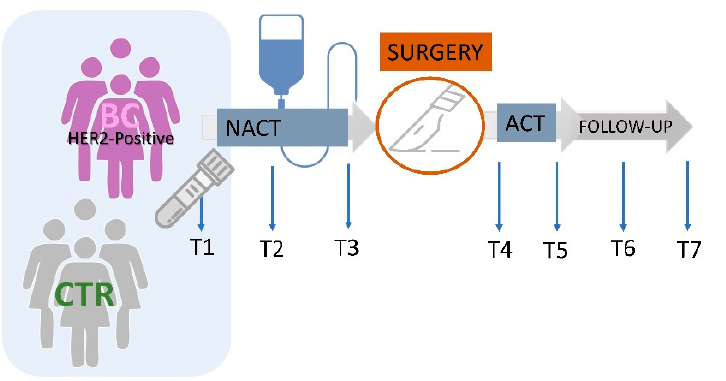
Figure 1. Schematic representation of the study. 1 H-NMR lipoproteins analysis was investigated in HER2-positive BC patients ( n = 43) at baseline (T1) and compared with those of the CTR group ( n = 28). In a subset of patients ( n = 32), plasma lipoproteins profiles were monitored during and after therapeutic interventions up to two-year follow-up: at baseline (T1), after three (T2) and six months (T3) from the start of NACT treatment, after two (T4) and six (T5) months from the surgery- ACT and at 1-year (T6) and two-year follow-up (T7).